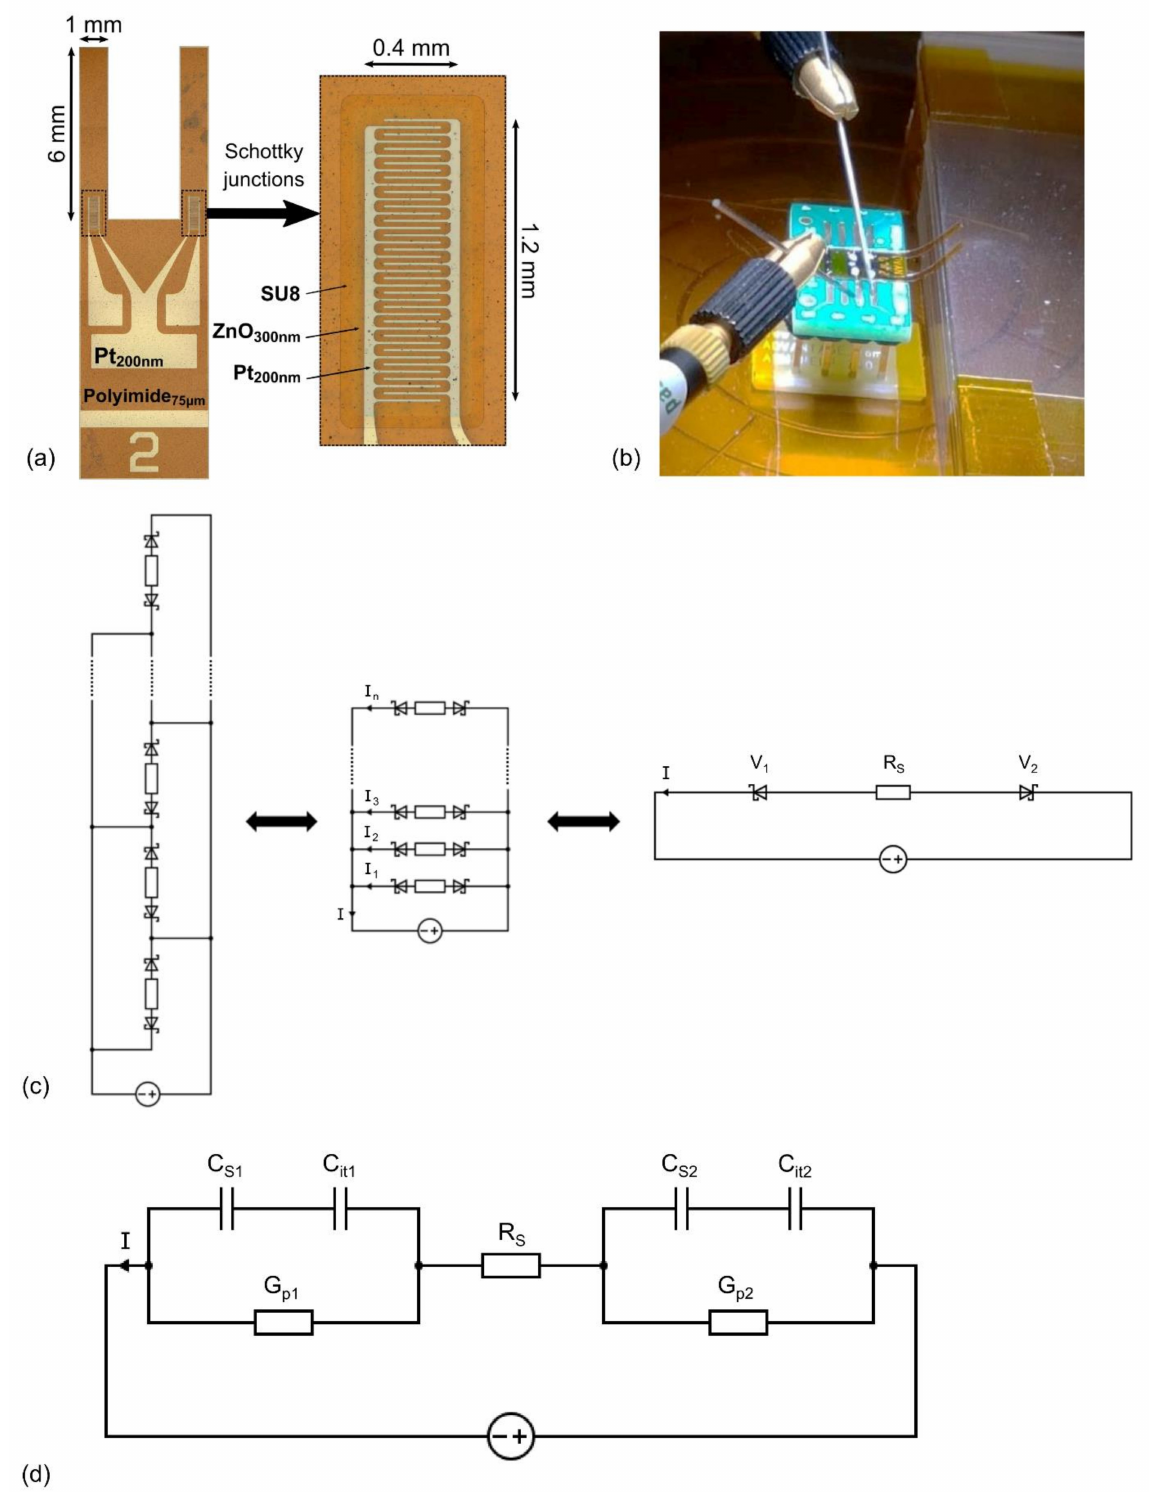
Figure 1. ( a ) Top view representation of a piezotronic strain microsensor. The black dashed line boxes represent a detailed view of the area of the interdigitated electrodes; ( b ) Piezotronic strain microsensor mounted and bonded on a printed circuit board (PCB), contacted with tungsten tips. The polyimide cantilevers are bent upwards, leading to the generation of a compressive strain; ( c ) Equivalent circuit model of the metal-semiconductor-metal structure with interdigitated electrodes; ( d ) Constitutive capacitance and conductance contributions from each Schottky